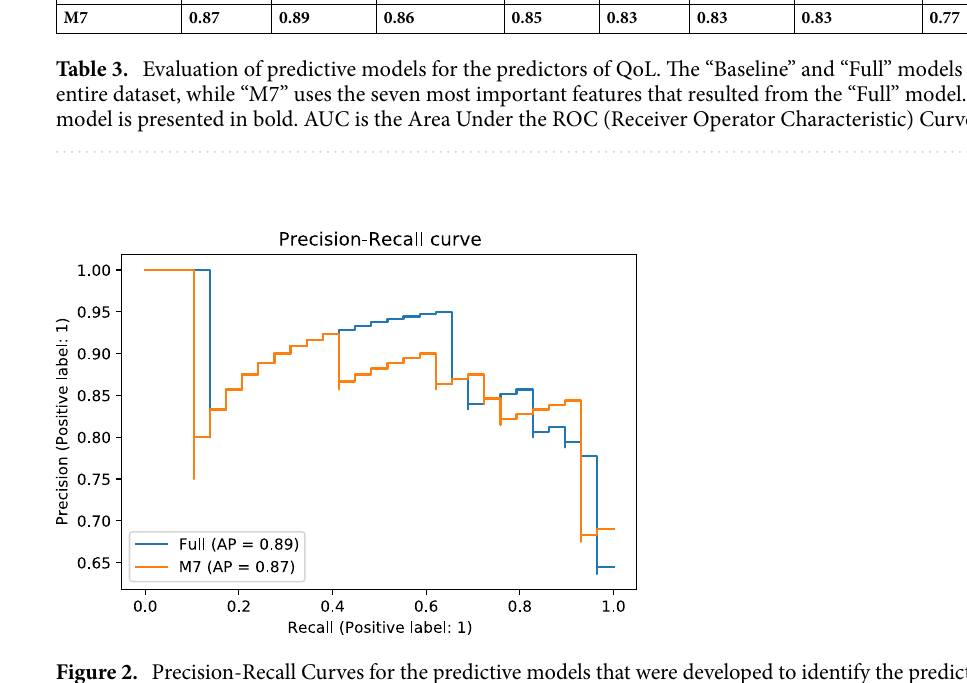
Figure 2. Precision-Recall Curves for the predictive models that were developed to identify the predictors of